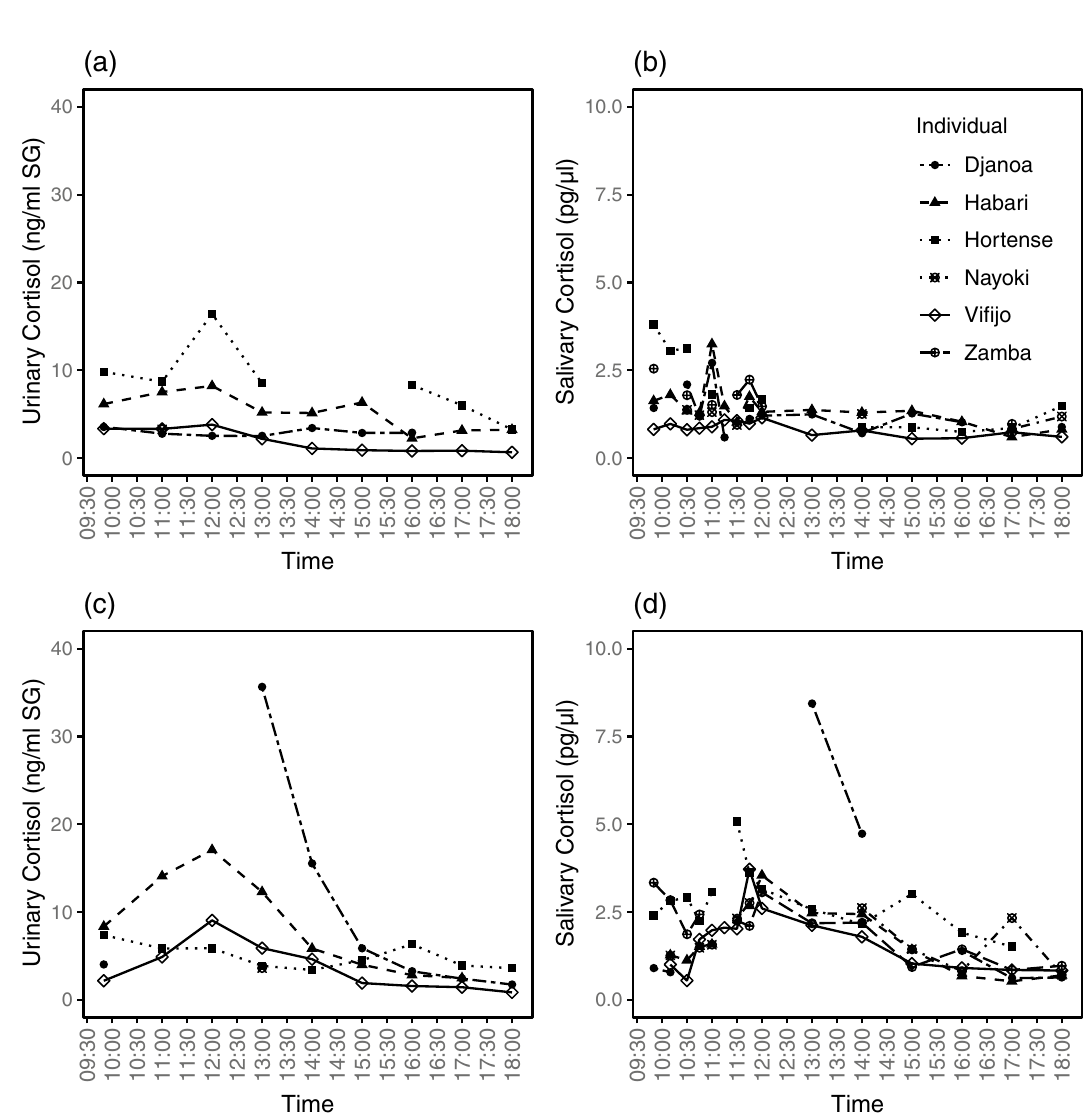
Figure 3. Individual cortisol levels in ( a ) urine during the control day; ( b ) saliva during the control day; ( c ) urine during the test day; and ( d ) saliva during the test day. In the test day, the stressor entered the building at 10:18. The analyses were conducted on log transformed cortisol data but actual values are displayed here to provide better visual and interpretable representation of the cortisol